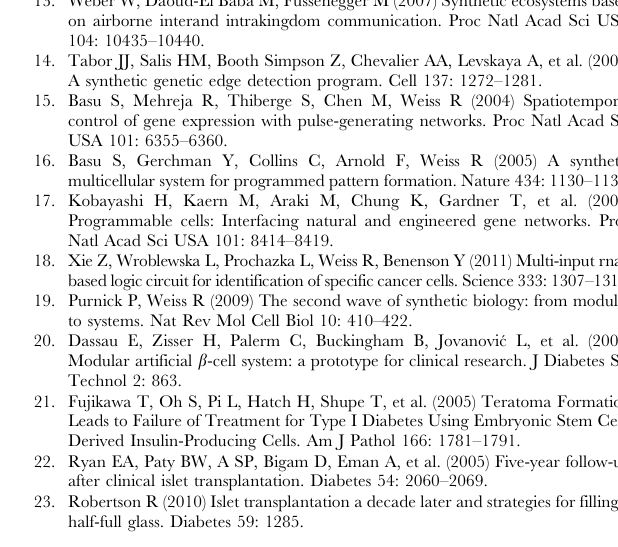
Table S4 Phenotypes for the oscillator module (see Figure 8A).